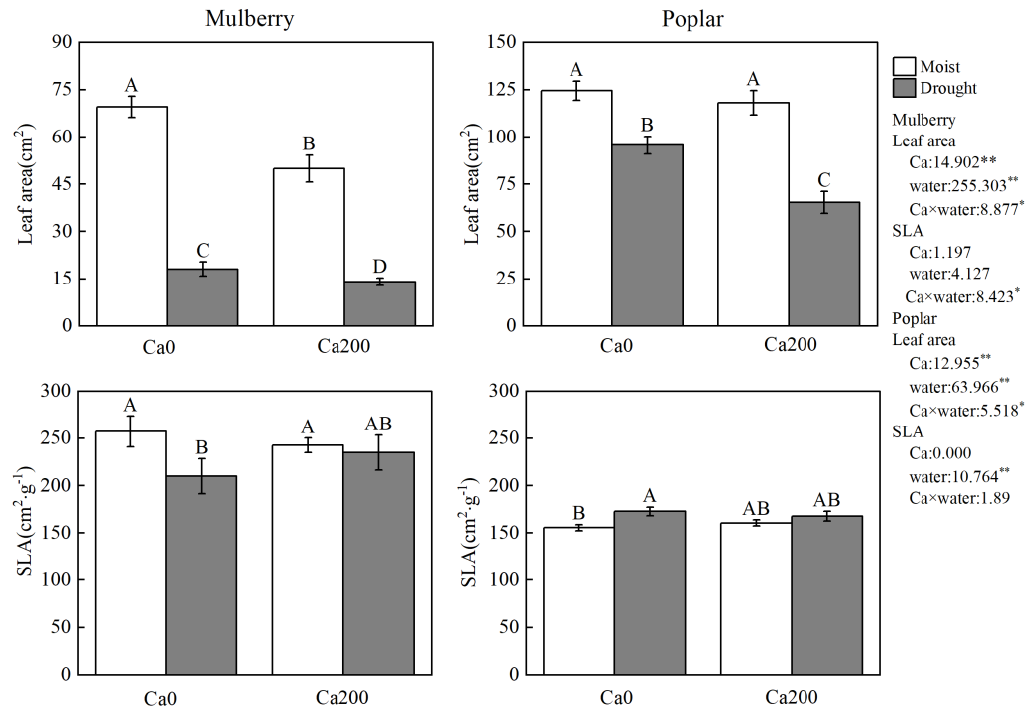
Figure 4. Effects of water and Ca treatments on leaf characteristics of the two species. Different letters indicate significant differences ( p < 0.05) among treatments. Treatment values shown as mean ± SE (n = 6). Results of two − way ANOVA addressing effects of Ca and water treatments are summarized on the right side. *, ** indicate that the F value is significant at p ≤ 0.05 and 0.01, respectively.